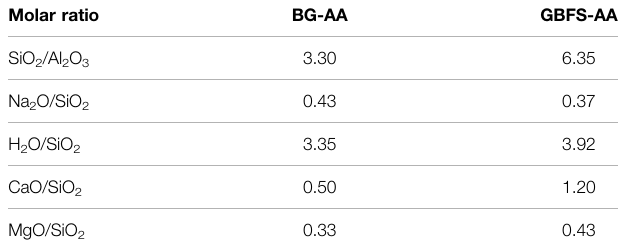
TABLE 2 | Chemical composition of the synthesised